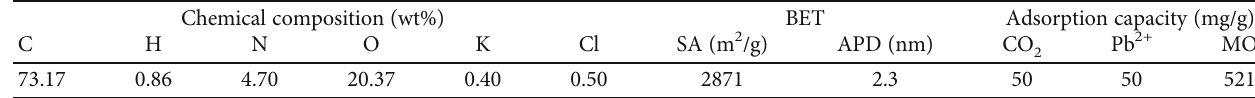
Table 1: Properties of PACK.